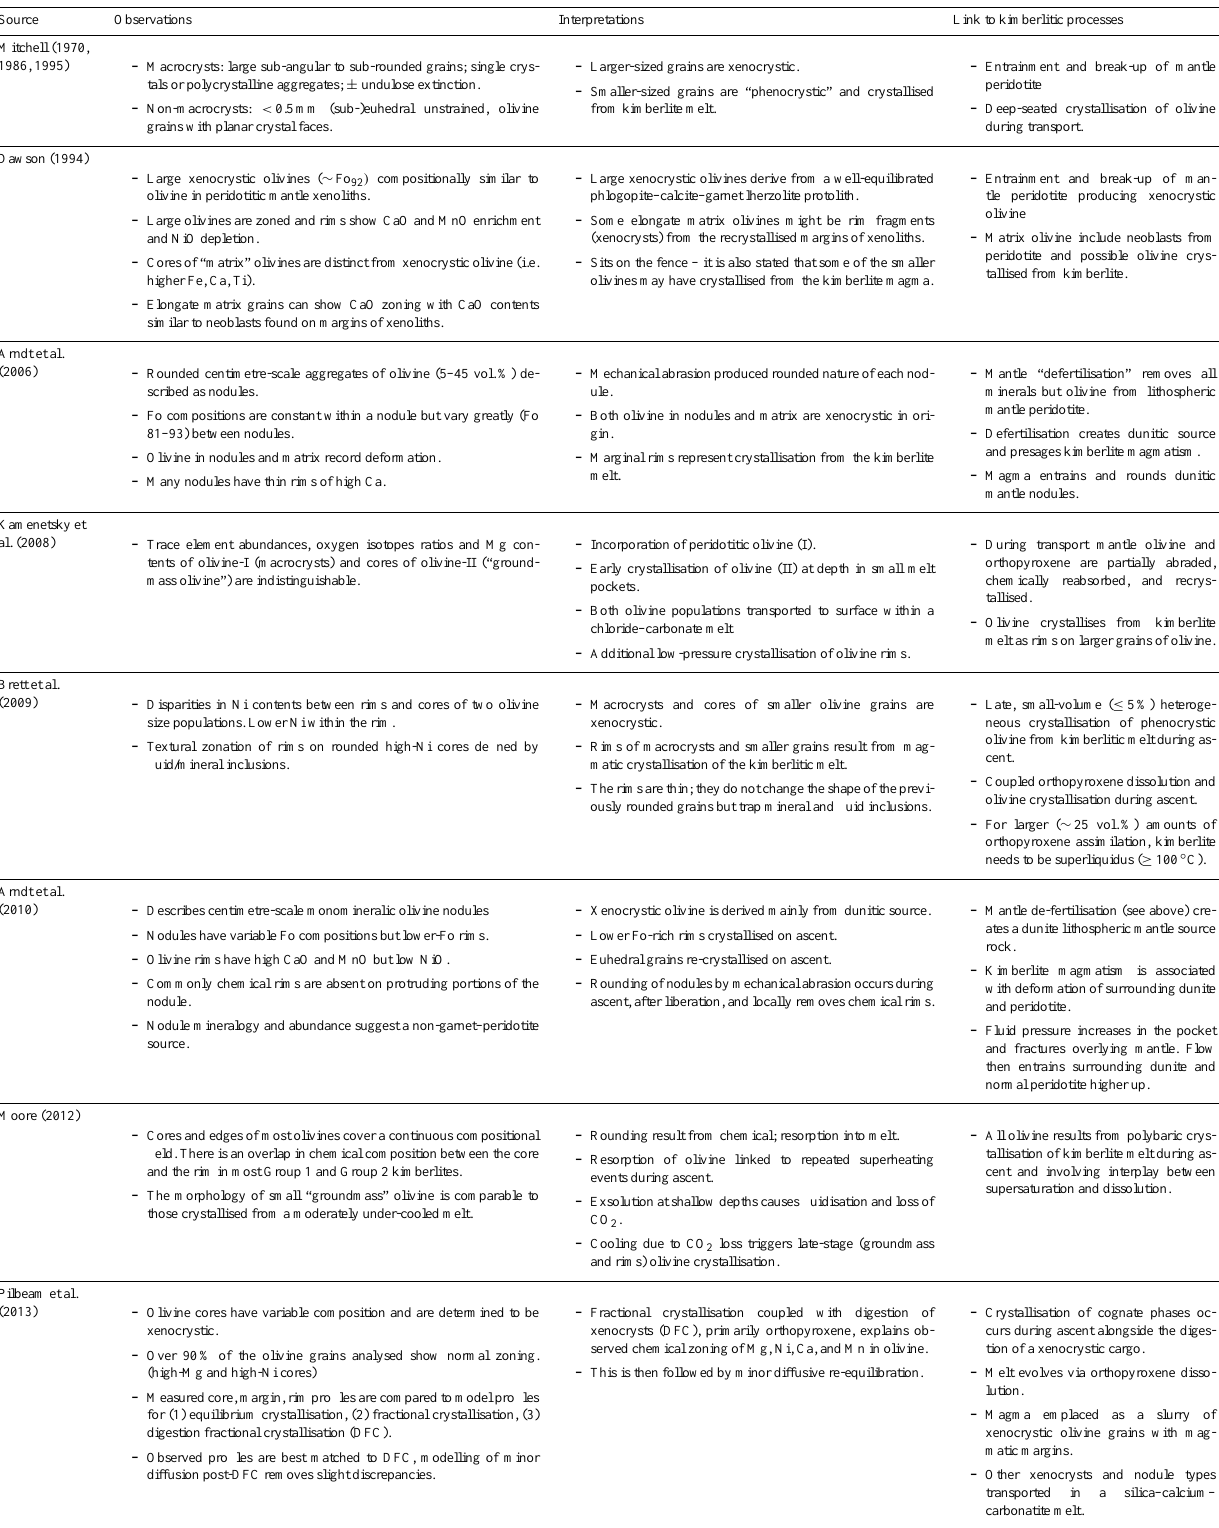
Table 1. Results from published studies of kimberlite-hosted olivine. The observations and interpretations reported below are filtered for their relevance to the kimberlitic ascent processes elucidated in our